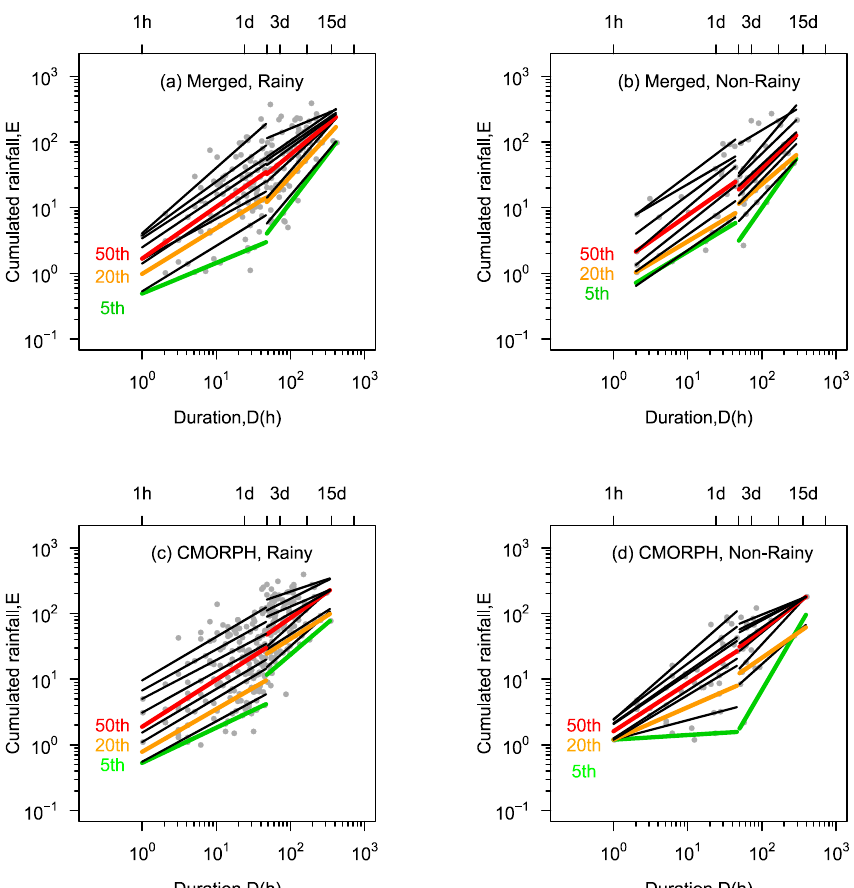
Figure 3. Event–duration (E–D) conditions of landslides calculated by the merged rainfall in the ( a ) rainy season and ( b ) non-rainy season, and by the Climate Prediction Center Morphing (CMORPH) rainfall in the ( c ) rainy season and ( d ) non-rainy season with different quantile regression lines (5%, 10%, 20%, 30%, 40%, 50%, 60%, 70%, 80% and 90% from bottom to top).